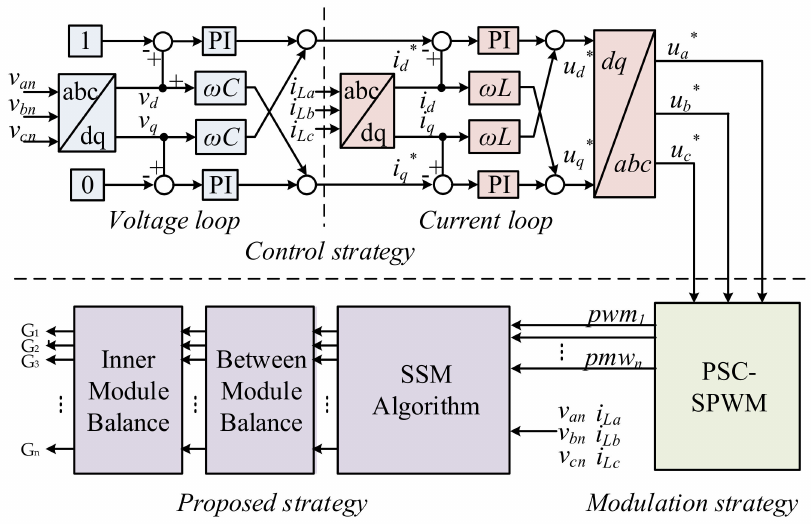
Figure 3. Control scheme of